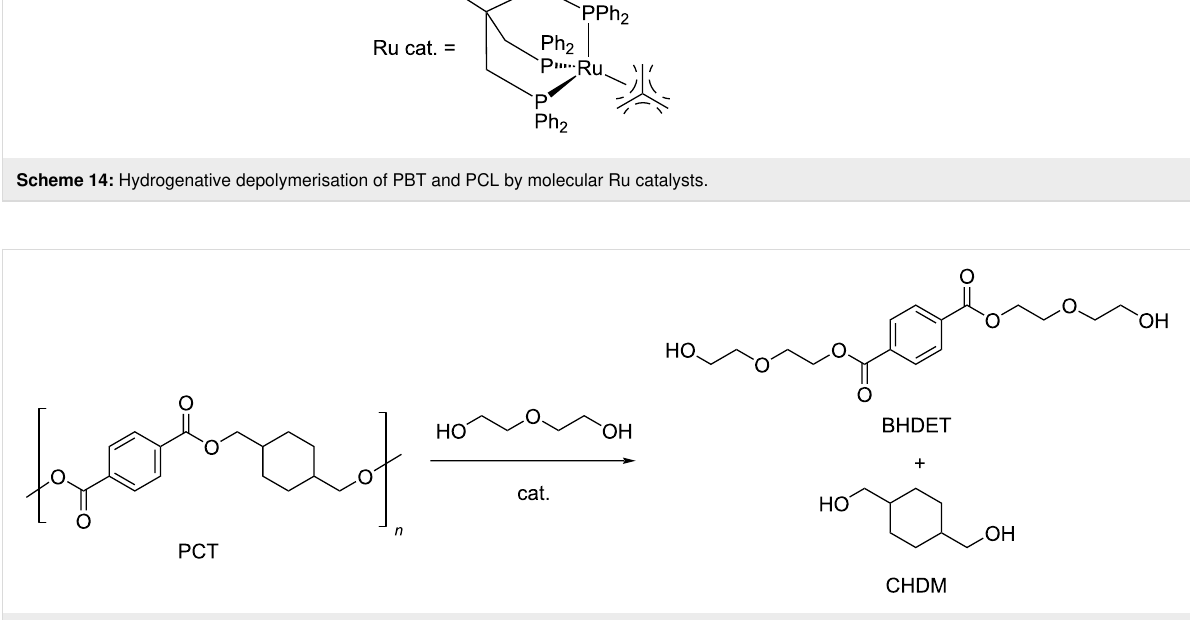
Scheme 15: Glycolysis reaction of PCT by diethylene